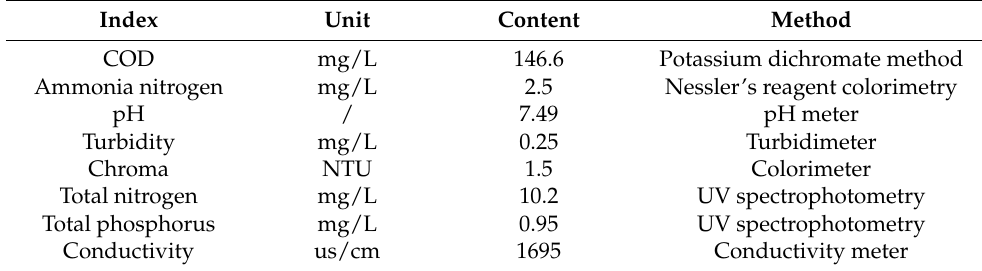
Table 1. RO concentrated water